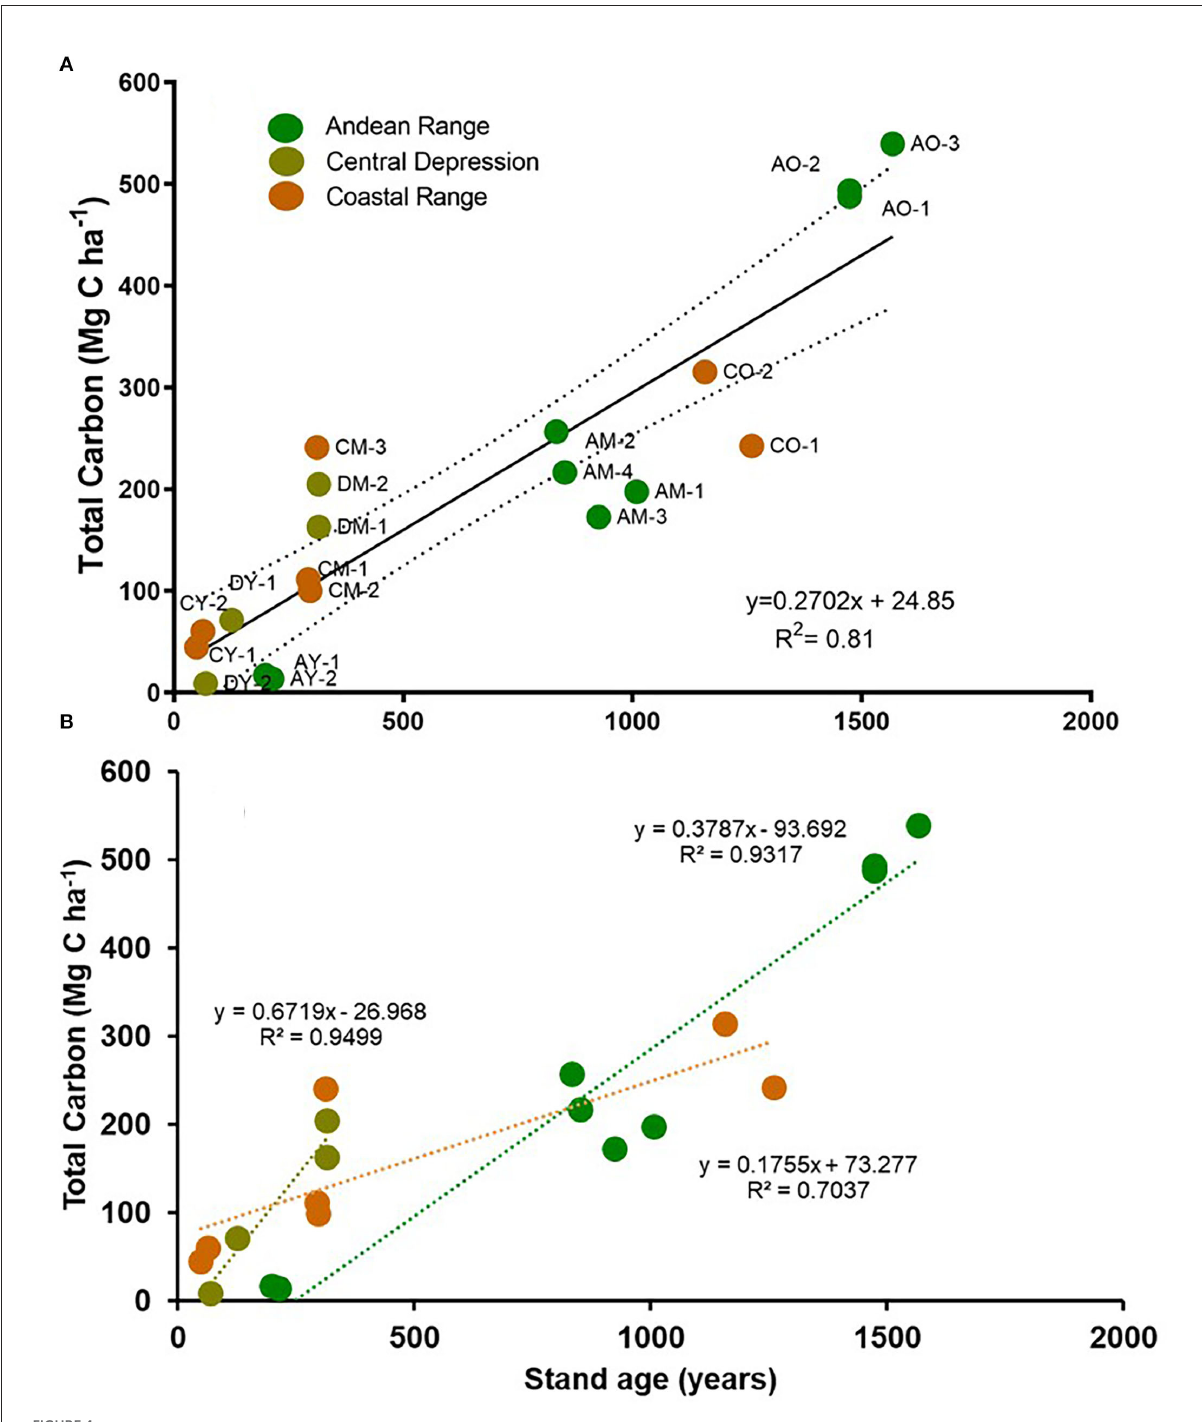
FIGURE4 Total carbon stocks related to stand age for (A) all Fitzroya stands studied in the three physiographic units. Each dot represents a plot. Stand age was determined from the maximum age of any tree in the plot belonging to the cohort. Dotted lines represent the confidence interval ( P < 0.05); (B) Fitzro ya stands from each physiographic unit, separately. Regression dotted lines are indicated as follows: Coastal range (orange), Central depression (dark green), and Andean range (light green). Old-growth stands in the central depression are not included neither in (A) or (B) since their maximum age could not be determined due to the hollow rotten center of the large stumps (200–280cm in